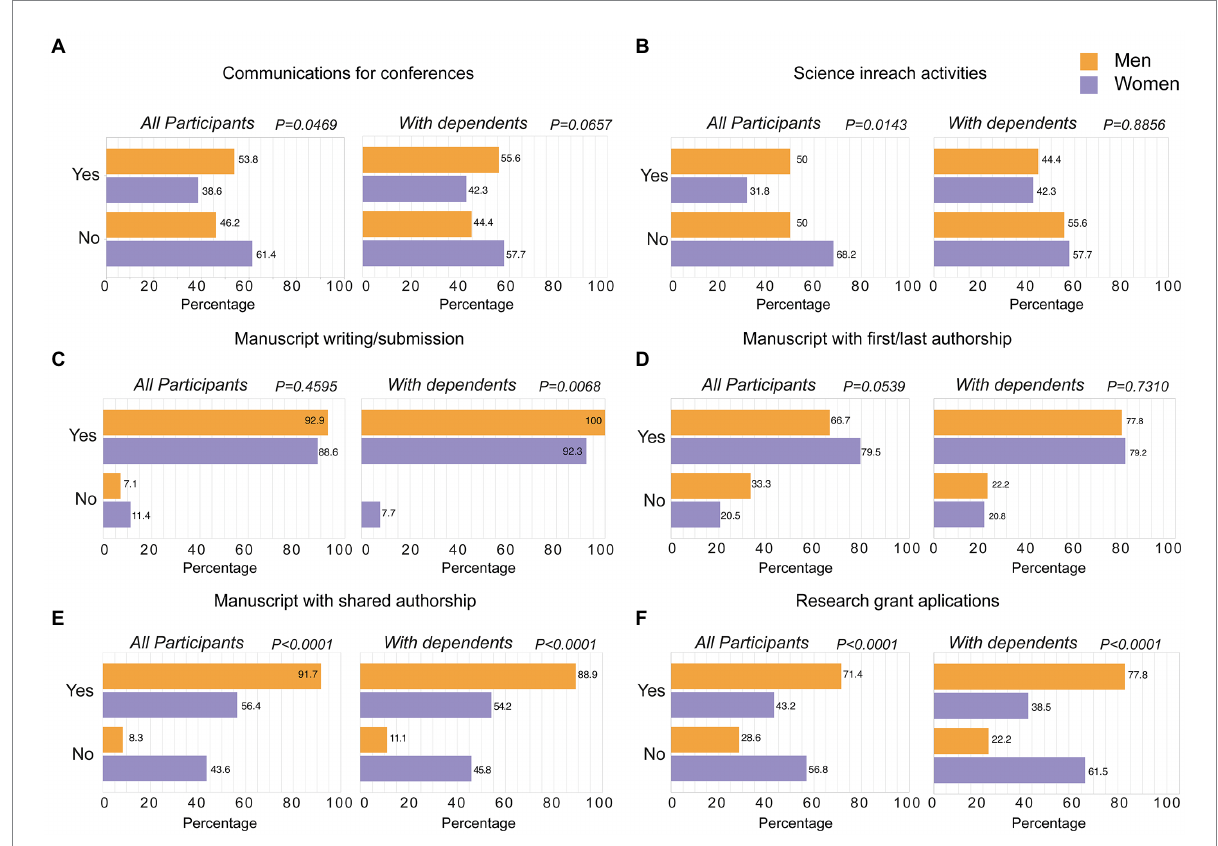
FIGURE 1 Impact of COVID-19 lockdowns in career development activities for scientists. (A–F) The indicated activities were analyzed in the subset of participants performing professional research activities ( n = 59; left) and only those with professional research activities and children or dependents at care ( n = 35; right). Numbers in each bar show the percentage of men (orange bars) and women (purple bars) who did (Yes) or not (No) each of the activities analyzed. Statistical differences in the distributions between men and women were analyzed with Fisher’s exact